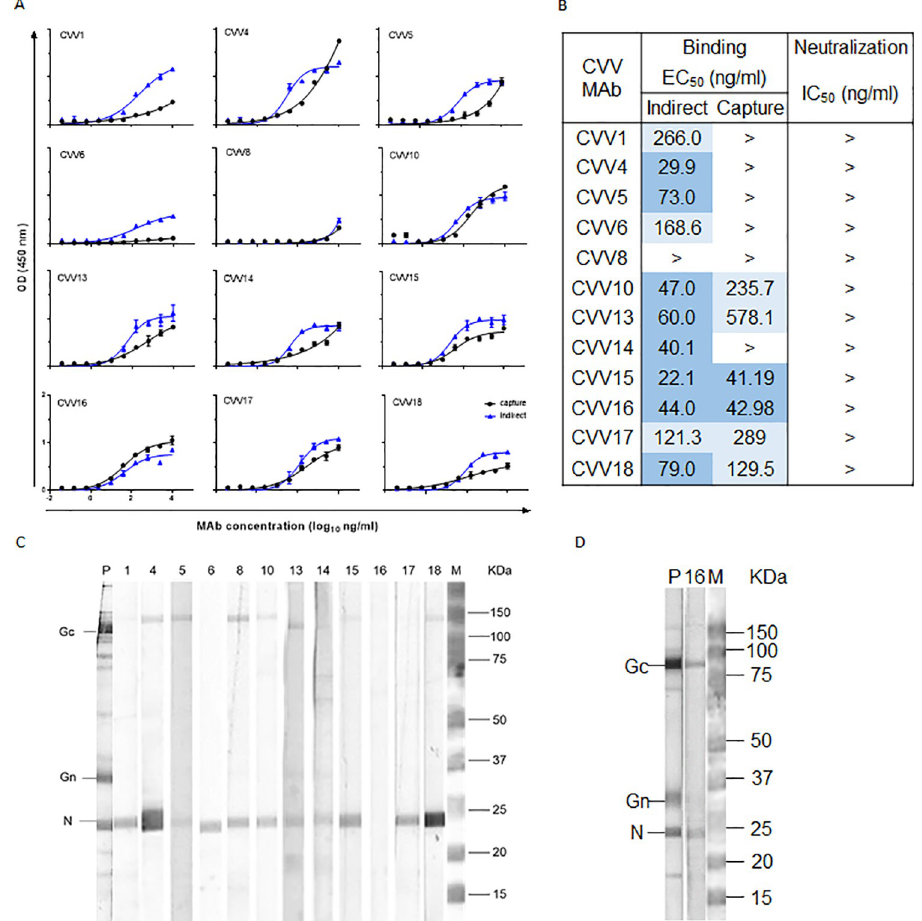
Fig 2. Binding, neutralization reactivity, and protein specificity of anti-CVV MAbs. A) Binding of anti-CVV MAbs to purified virus was determined by indirect (blue) and capture (black) ELISA. B) EC 50 and IC 50 values (shown as MAb concentrations of ng/mL) in ELISA and PRNT were determined by non-linear fit analysis, with the bottom of the curve constrained to 0 for both analyses and the top of the curve constrained to 100 for neutralization analysis, using GraphPad Prism software V6. Dark blue: EC 50 values < 100 ng/mL. Light blue: EC 50 values 100–10,000 ng/mL. > indicates no detectable reactivity at 10,000 ng/mL. C) Western blot of reduced purified CVV with anti-CVV MAbs was prepared as described in Materials and Methods. Lane nomenclature corresponds to MAb nomenclature. D) Western blot of non-reduced purified CVV with MAb CVV16, P (positive control (CVV MHIAF)), M (Bio-Rad Precision